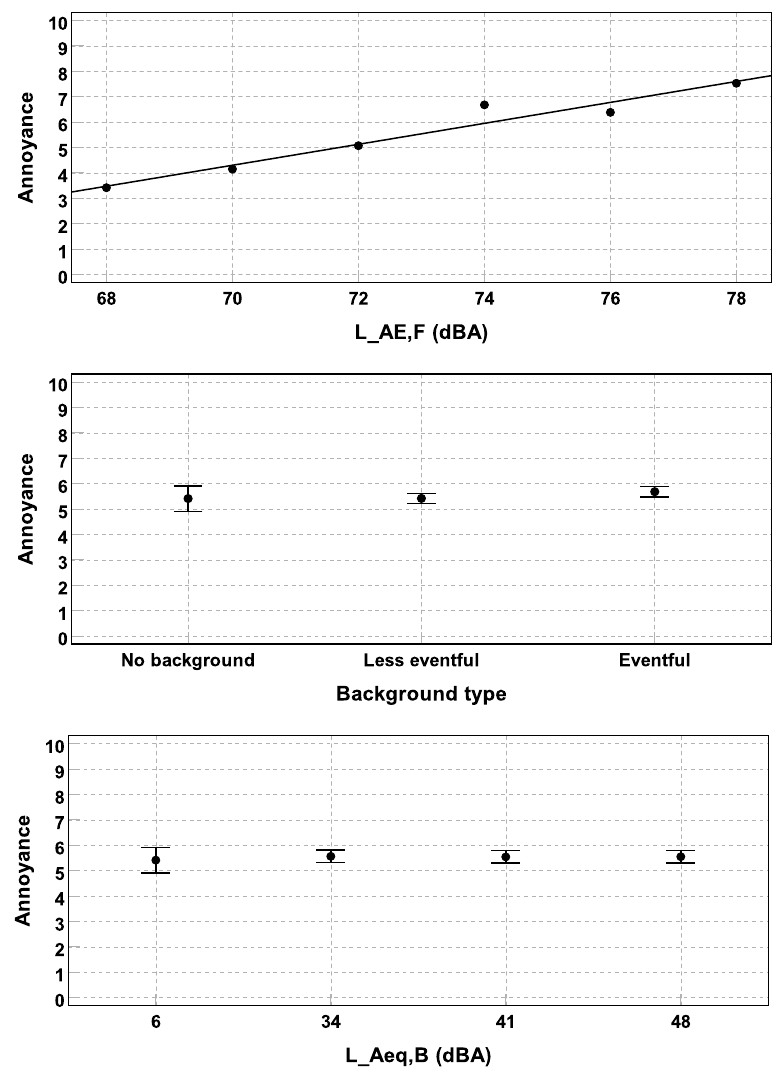
Figure 4. Results of experiment 1: mean acoustic comfort ratings across subjects (and their 95% confidence intervals) are shown as a function of L AE,F ( above ) or for different background types ( middle ) and L Aeq,B ( below ). Table 2. Experiment 1, model 1: model coefficients (Coeff.), their 95% confidence interval (CI), and probabilities ( p ) of the linear mixed effects model for annoyance. The parameters and symbols are explained in Equation (1). Parameter Symbol Coeff. 95%